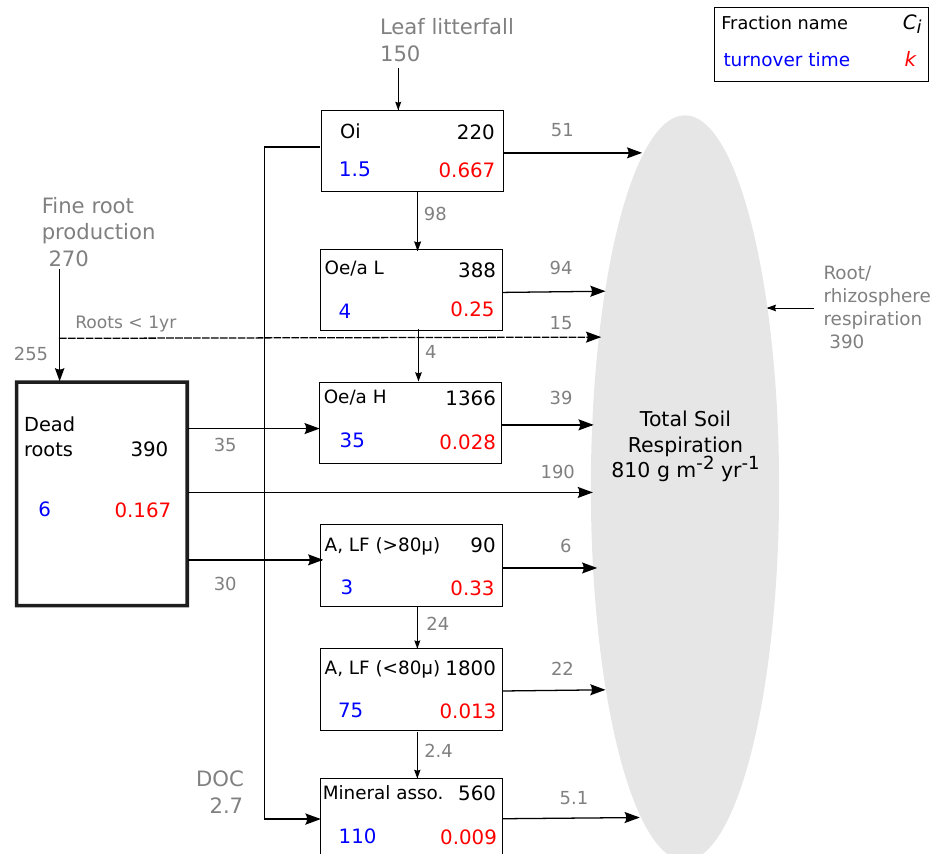
Fig. 1. Empirical model of soil carbon dynamics at Harvard Forest proposed by Gaudinski et al. (2000). The model consists of 6C fractions plus a dead fine root pool. Fluxes are represented in gray (units of gCm − 2 yr − 1 ) while the amount of carbon at each fraction ( C i ) in black (gCm − 2 ). Turnover times (yr) and decomposition rates (yr − 1 ) are represented in blue and red, respectively. “L” refers to the > 80µm fraction and “H” to < 80µm fractions in the organic layer. Note that the turnover time and decay rate of fine dead roots do not match the stocks and input rates. This mismatch is due to 1 14 C values in fine roots far from the atmospheric value that suggests a turnover time of 6 years. This issue is well discussed in Gaudinski et al.